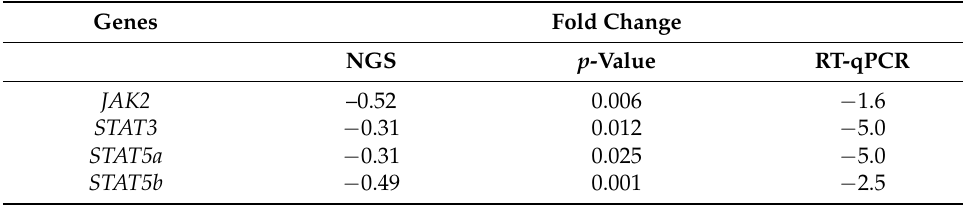
and Figure 6. These results were consistent with the NGS results.